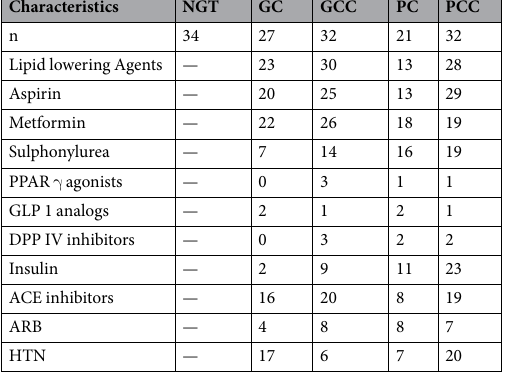
Table 2. Baseline characteristics: medications and HTN in different subgroups. PPAR γ agonists, Peroxisome proliferator-activated receptor gamma agonists, GLP-1 analogs, Glucagon-like peptide-1 analogs, DPP IV inhibitors, Inhibitors of dipeptidyl peptidase 4, ACE inhibitor, Angiotensin-converting-enzyme inhibitor, ARB, angiotensin receptor blockers, HTN, Hypertension.